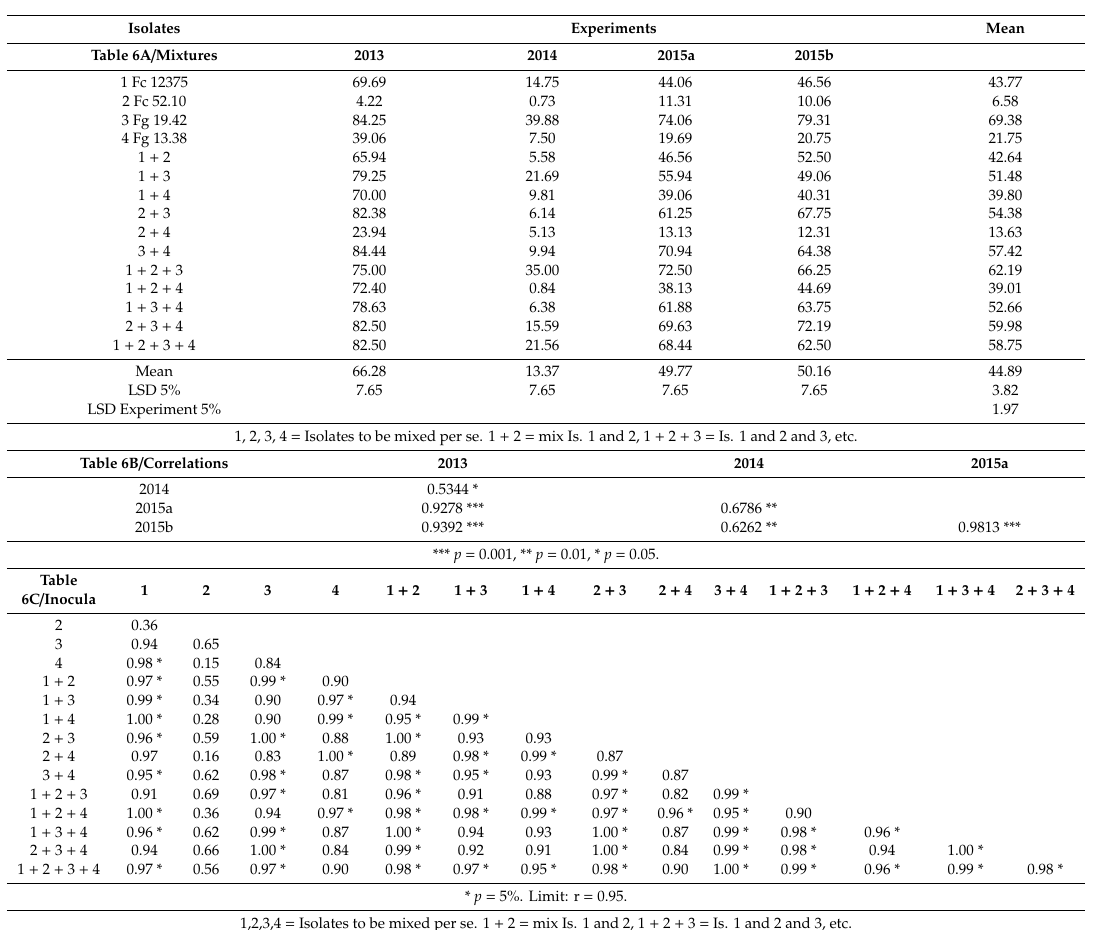
Table 6. Response of wheat to the di ff erent isolates and their mixtures. FDK data (%) of the experiments across wheat cultivars, Szeged, 2013–2015. Isolates Experiments Mean Table 6A / Mixtures